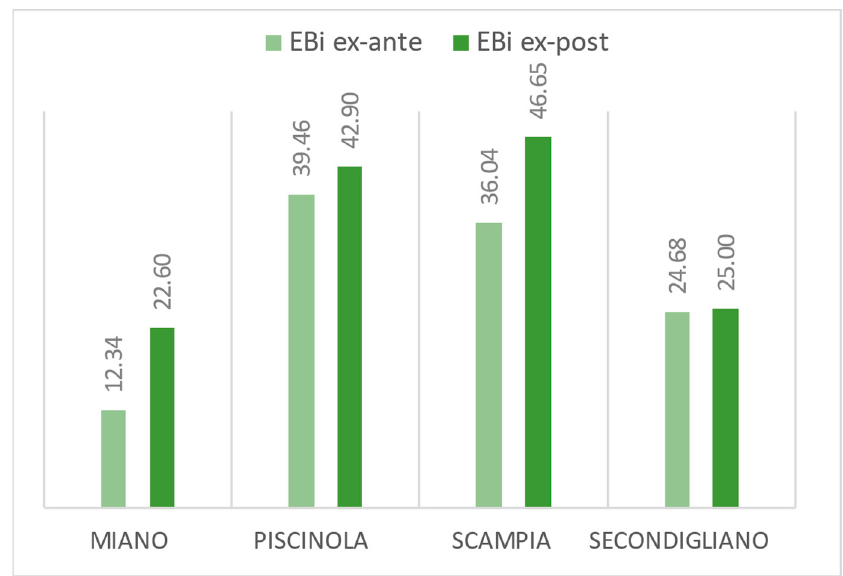
Figure 9. Analysis of the ecological benefit index following the first intervention strategy testing.